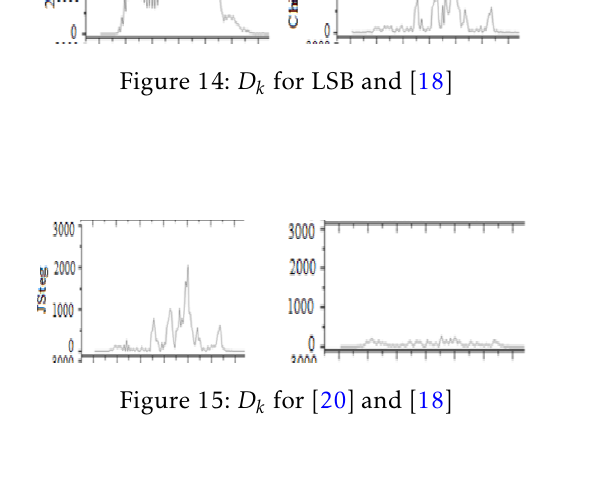
Figure 14: D k for LSB and [18]